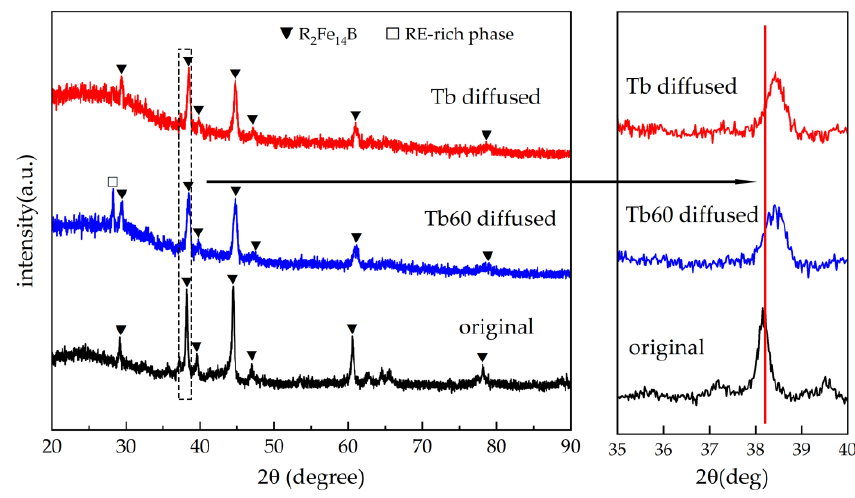
Figure 2. The X-ray diffraction patterns of the original and the Tb60 and Tb diffusion magnets.